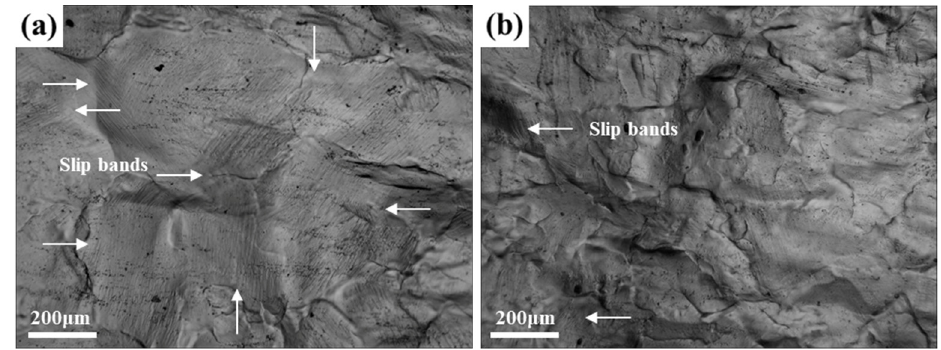
Figure 11. OM observations on the surface of the Cl sample of TDSP tensioned to a strain of 0.12 at different temperatures: ( a ) 25 °C; ( b ) − 196 °C.